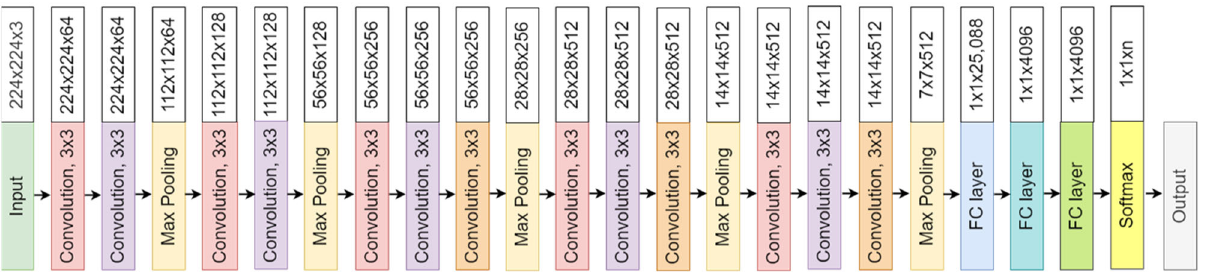
Figure 5. VGG16 architecture.